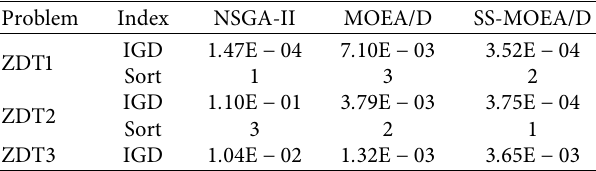
Table 2: Comparison of IGD